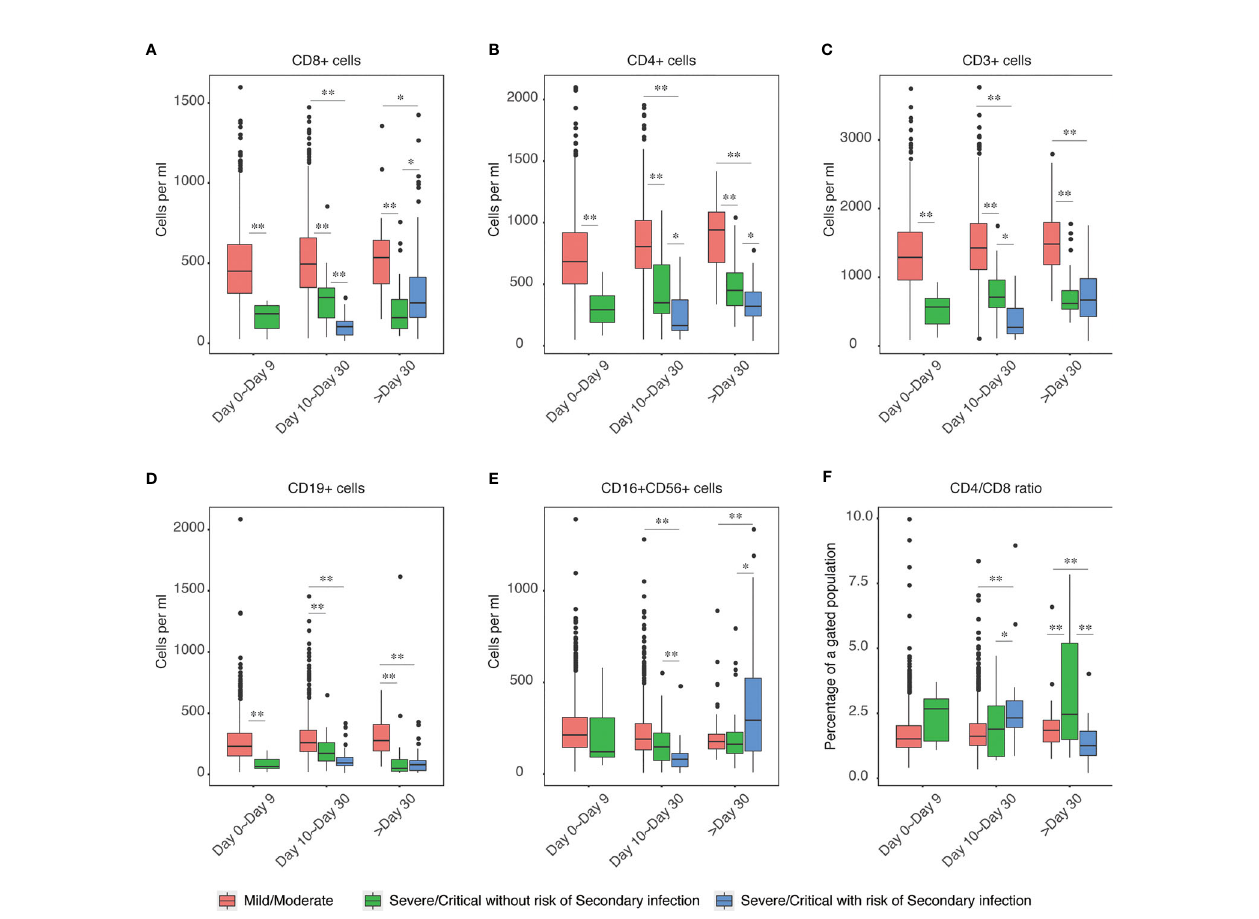
FIGURE 3 | Elevation of lymphocytopenia enhanced the risk of secondary infection. The levels of CD4+ (A) , CD8+ (B) , CD3+ (C) , CD19+ (D) , CD16+CD56+ (E) and CD4+/CD8+ (F) ratio in mild/moderate COVID-19, severe/critical COVID-19 without risk of secondary infection and severe/critical COVID-19 with the risk of secondary infection were shown. Each group of samples was further divided into three groups according to the time post-symptoms, including day 0 to day 9, day 10 to day 30, and post day 30. The barplot patients with the risk of secondary infection at day 0 to day 9 were not shown due to no available data. The chosen level of statistically signi fi cance were *P < 0.01 and **P < 0.05,